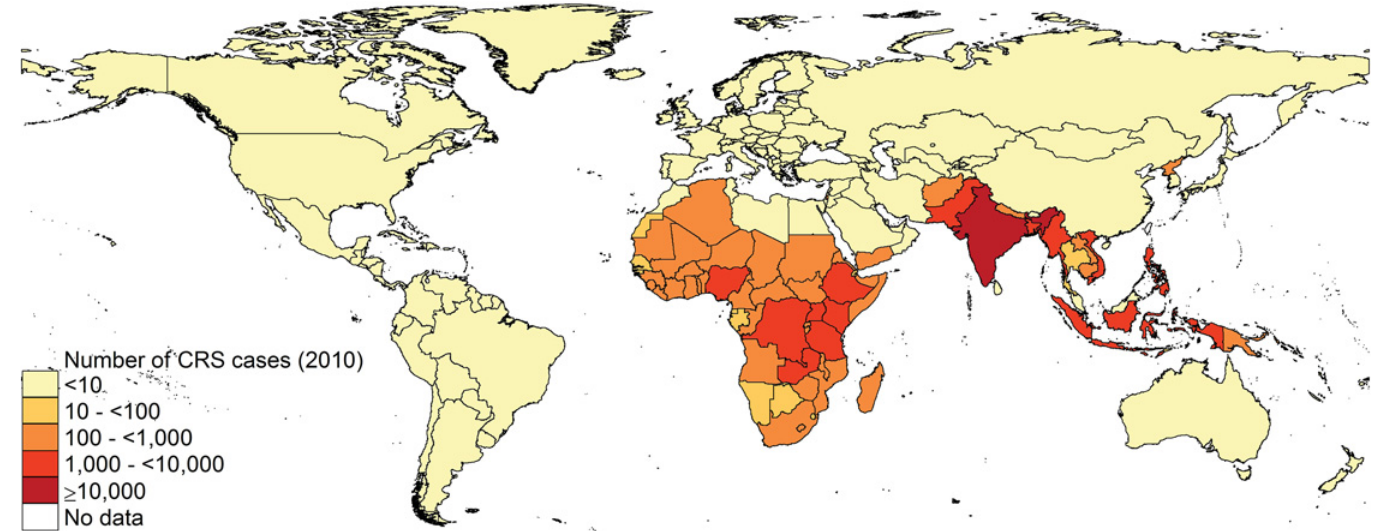
Fig 5. Estimates of the median numbers of CRS cases born by country in